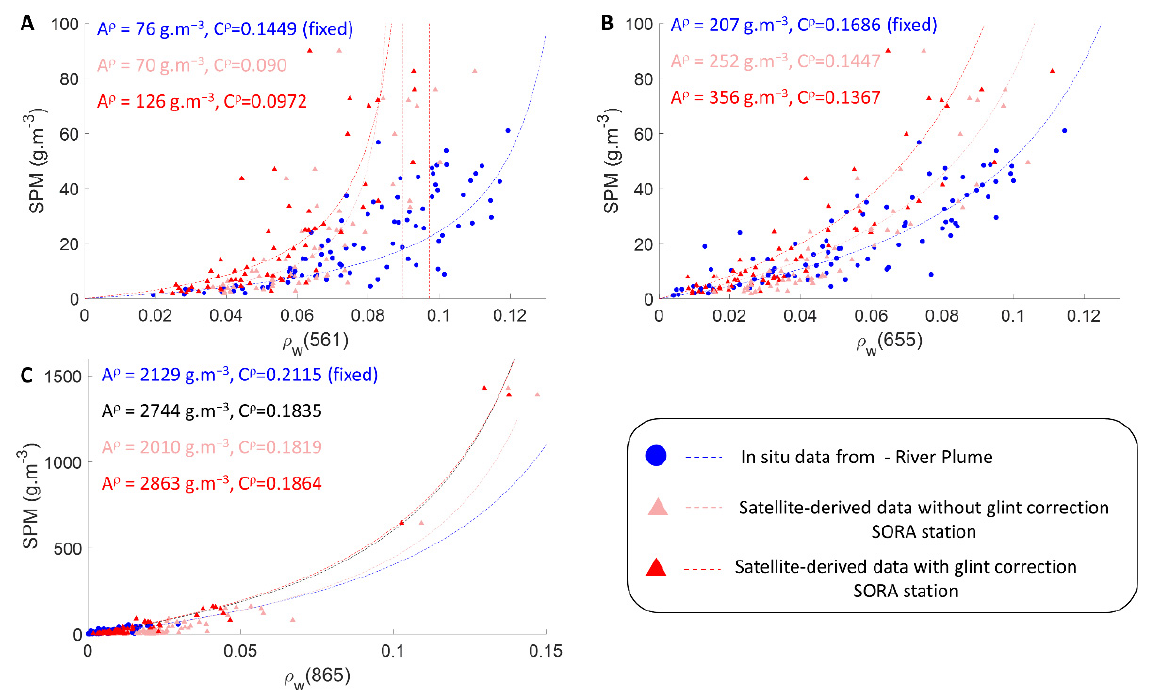
Figure A6. Percentile 95 values of SPM concentration (g.m − 3 ) for the twelve embedded areas. The shaded line corresponds to a concentration of 3 g.m − 3 and is considered to be the limit between the SPM concentration background and the SPM concentration of the turbid plume.